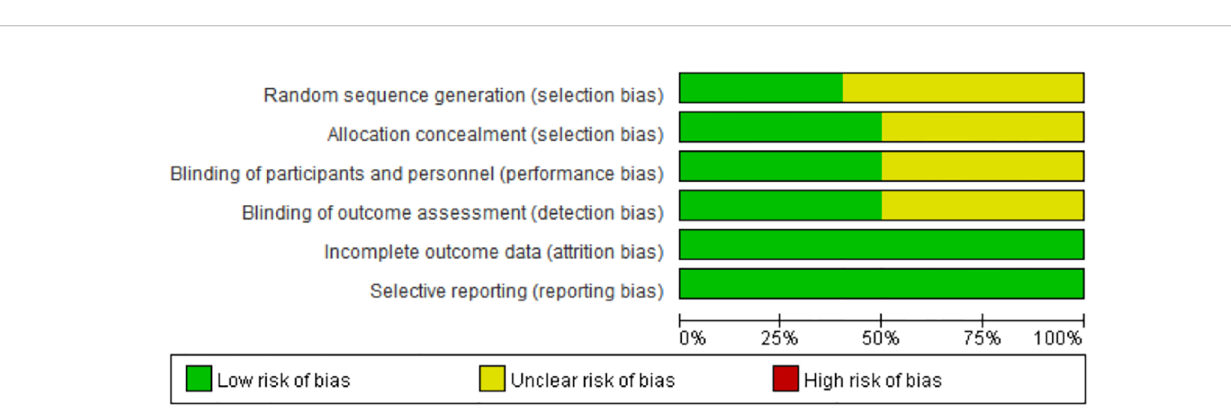
FIGURE 5 | Risk of bias graph: each risk of bias item presented as percentages across all included full reported studies.